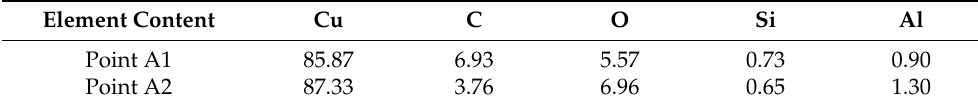
Figure 13. C17200 beryllium copper alloy fractured at 350 °C ( S max = 420 MPa, N f = 0.31 × 10 7 cycles). ( a ) General view of fatigue-fractured surface; ( b ) crack initiation region; ( c ) crack propagation region; ( d ) final rupture region; ( e ) EDS spectrum of point A1; and ( f ) EDS spectrum of point A2. Table 3. Element content of point A1 and A2 (wt. %).